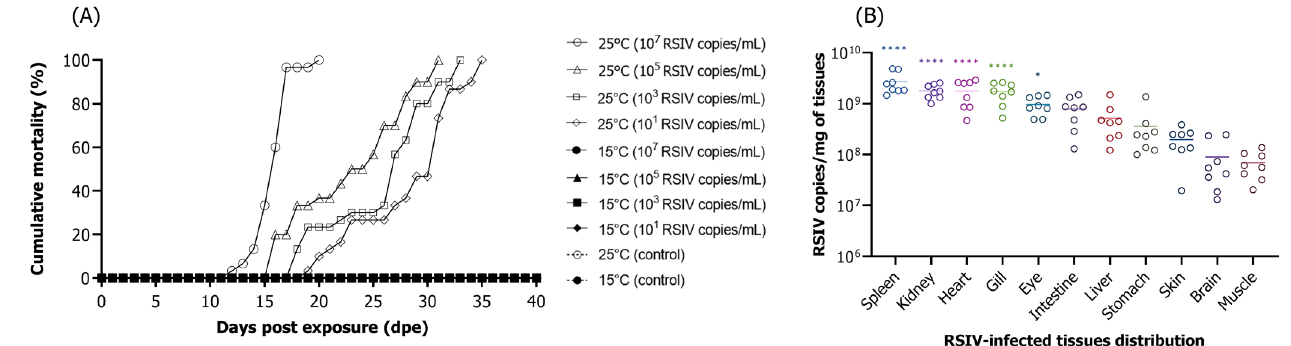
Figure 1. ( A ) The cumulative mortality of rock bream ( Oplegnathus fasciatus ), following immersion exposure with red sea bream iridovirus (RSIV) at 25 °C and 15 °C using four different viral concentrations (10 7 , 10 5 , 10 3 , and 10 1 RSIV copies/mL). The control group was not subjected to any treatment. ( B ) RSIV tissue distribution in rock bream that died due to RSIV is also shown. The mean viral copy numbers ( n = 8) are represented by bars, and asterisks are used to indicate significant differences (* p < 0.05; **** p < 0.0001) compared to the muscle.